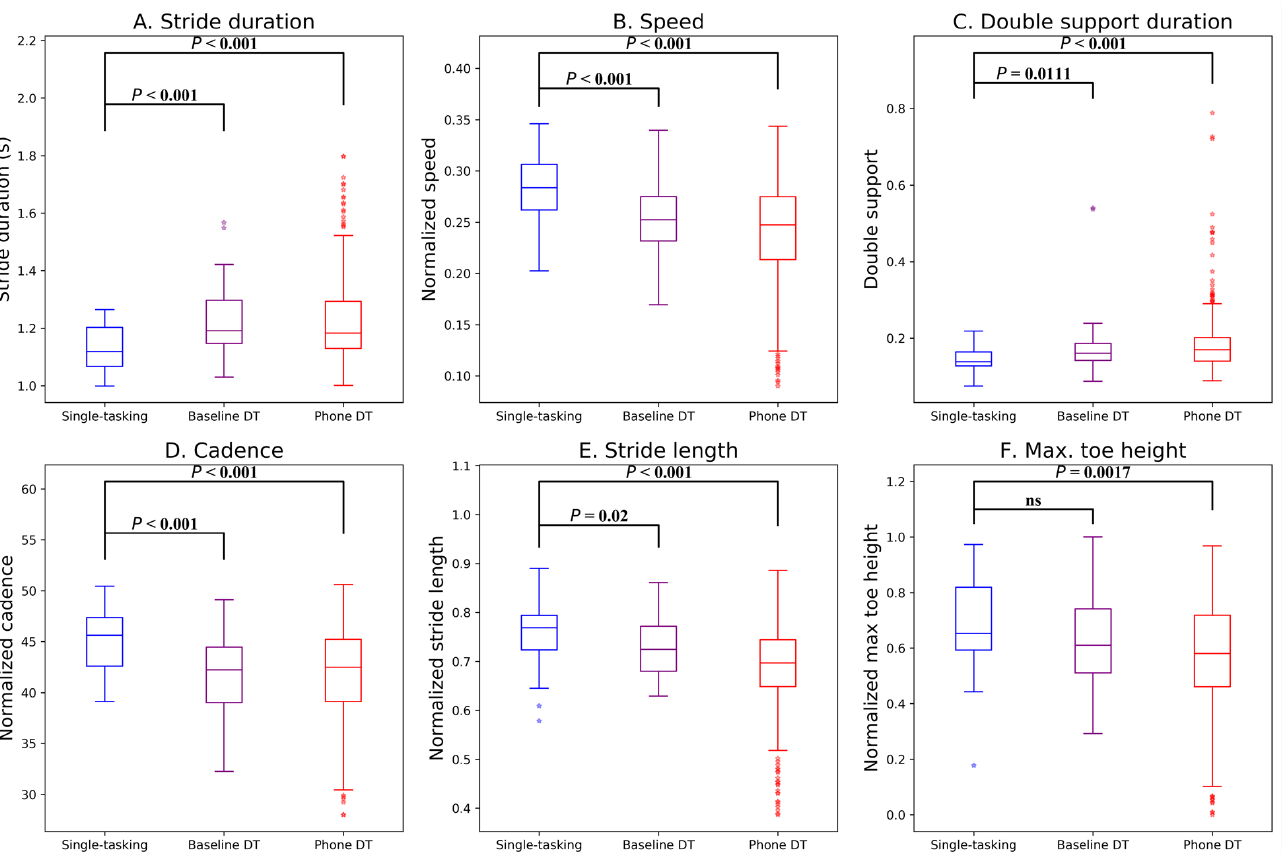
Figure 4. Boxplots with the effects of the baseline dual task and mobile phone dual task on single gait of the 6 gait variables with the highest significance (lowest p -value). The five-pointed stars represent outliers, which are data points that fall outside the upper and lower quartiles of the data set. See Appendix A, Table A1.